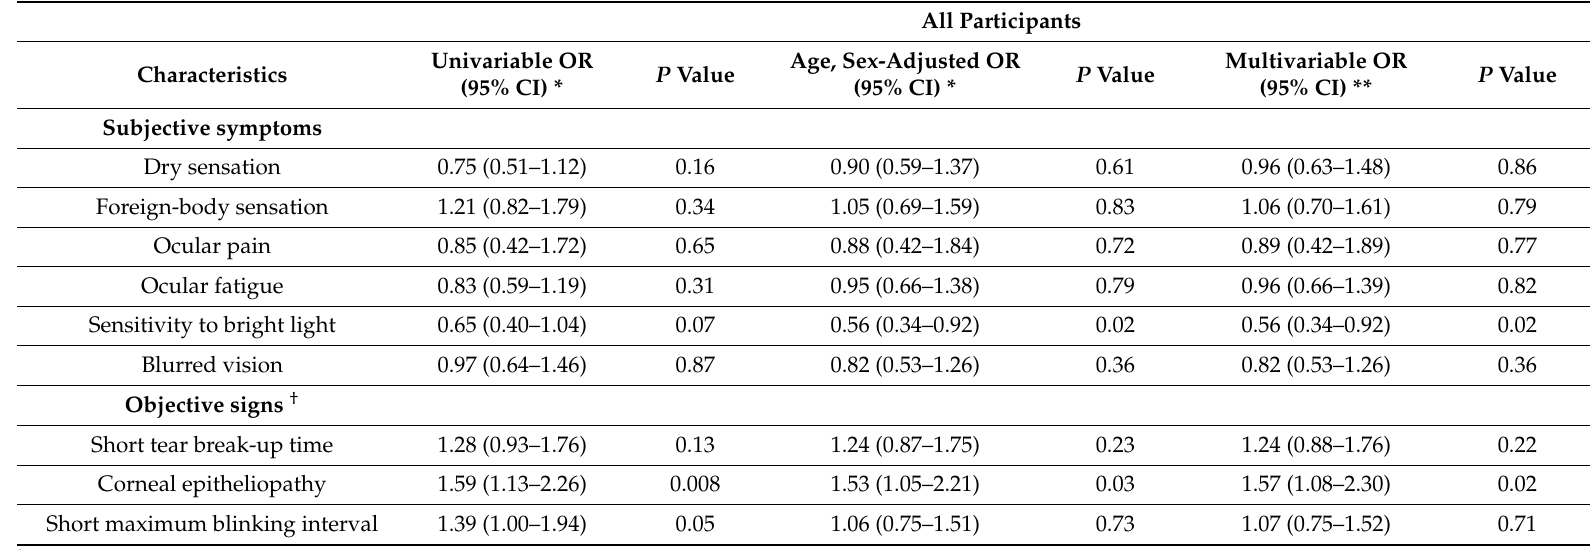
Table 2. Univariable and multivariable logistic regression analyses of dry eye subjective symptoms and objective signs in relation to the history of cataract surgeries.